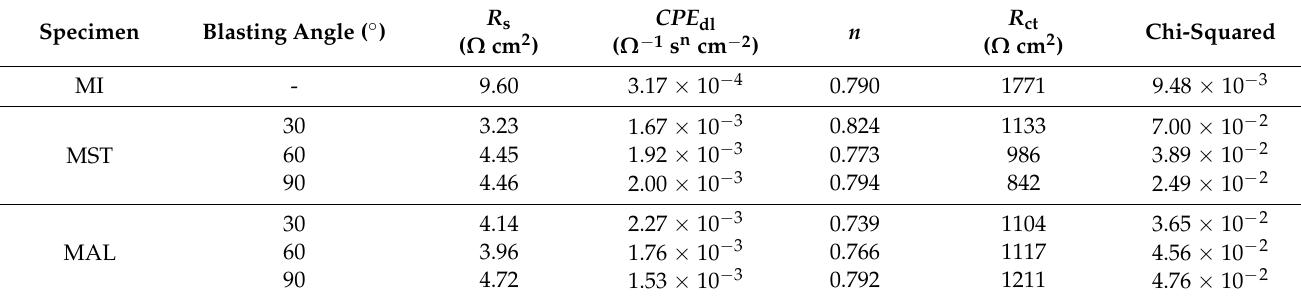
Figure 13. EIS measurements of the blasted specimens after immersing in 3.5 wt% NaCl solution for 1 h: ( a ) MST, ( b ) MAL. Table 7. Fitting result of EIS parameters for blasted